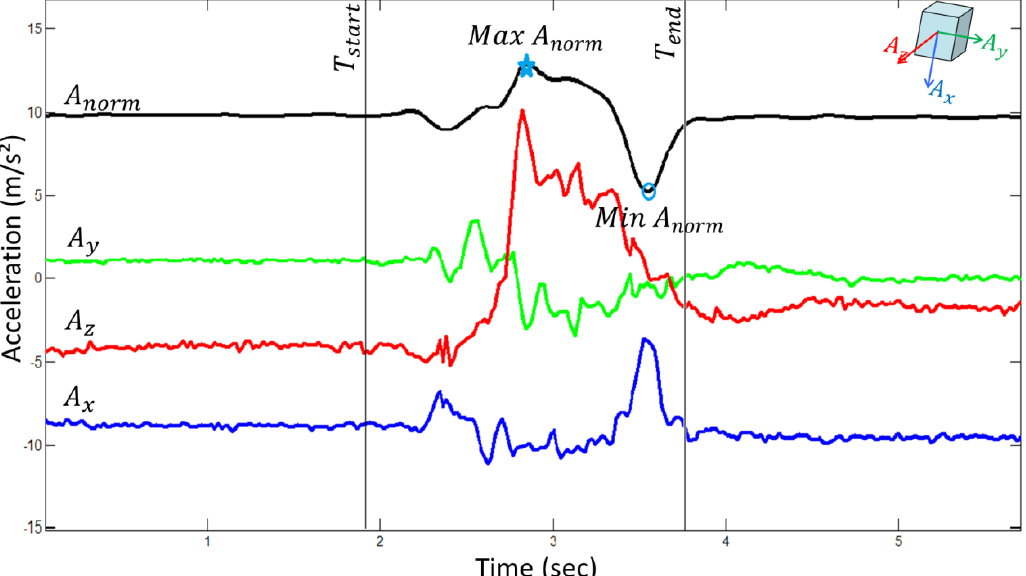
The definitions of the measurements are described